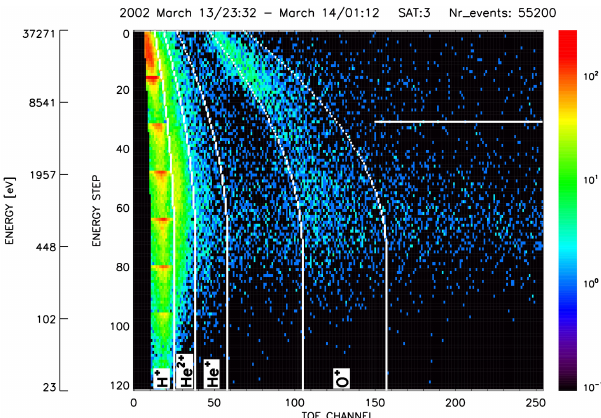
Figure 1. Raw events as a function of TOF and E/q collected during a time interval of 100min around the magnetopause tran- sition on 14 March 2002, to be analyzed in Sect. 4.1. The parabolic white lines delineate regions assigned to different M/q ranges, i.e., ions with M/q = 1 (H + ), M/q = 2 (He 2 + ), M/q = 4 (He + ), and M/q = 16 (O + ). The horizontal white line indicates the lower limit of the energy range used to compute the O +